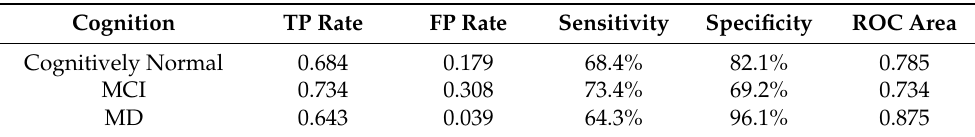
Table 3. Detailed accuracy for each cognitive clinical diagnosis when classifying among normal, MCI and MD (116 total instances).